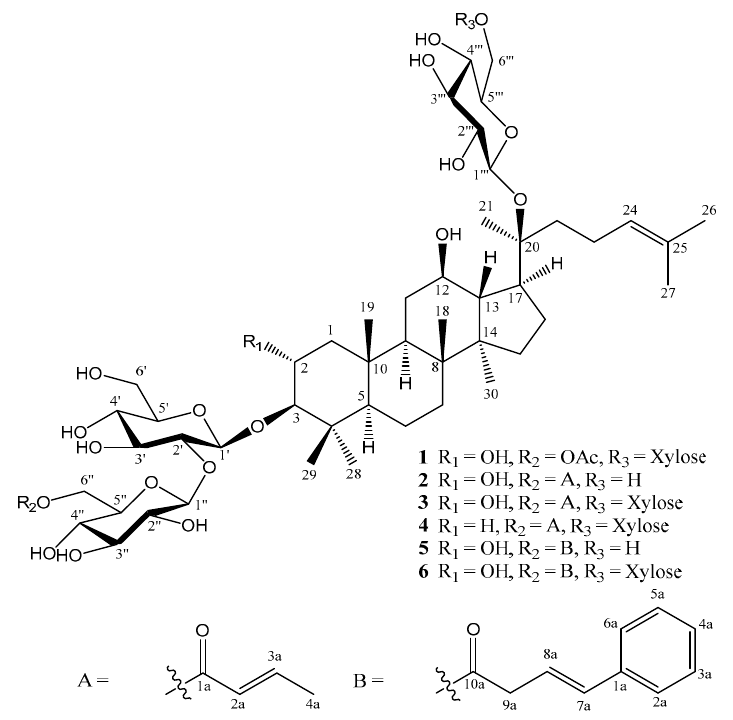
Figure 1. Chemical structures of compounds 1 – 6 isolated from G. pentaphyllum .